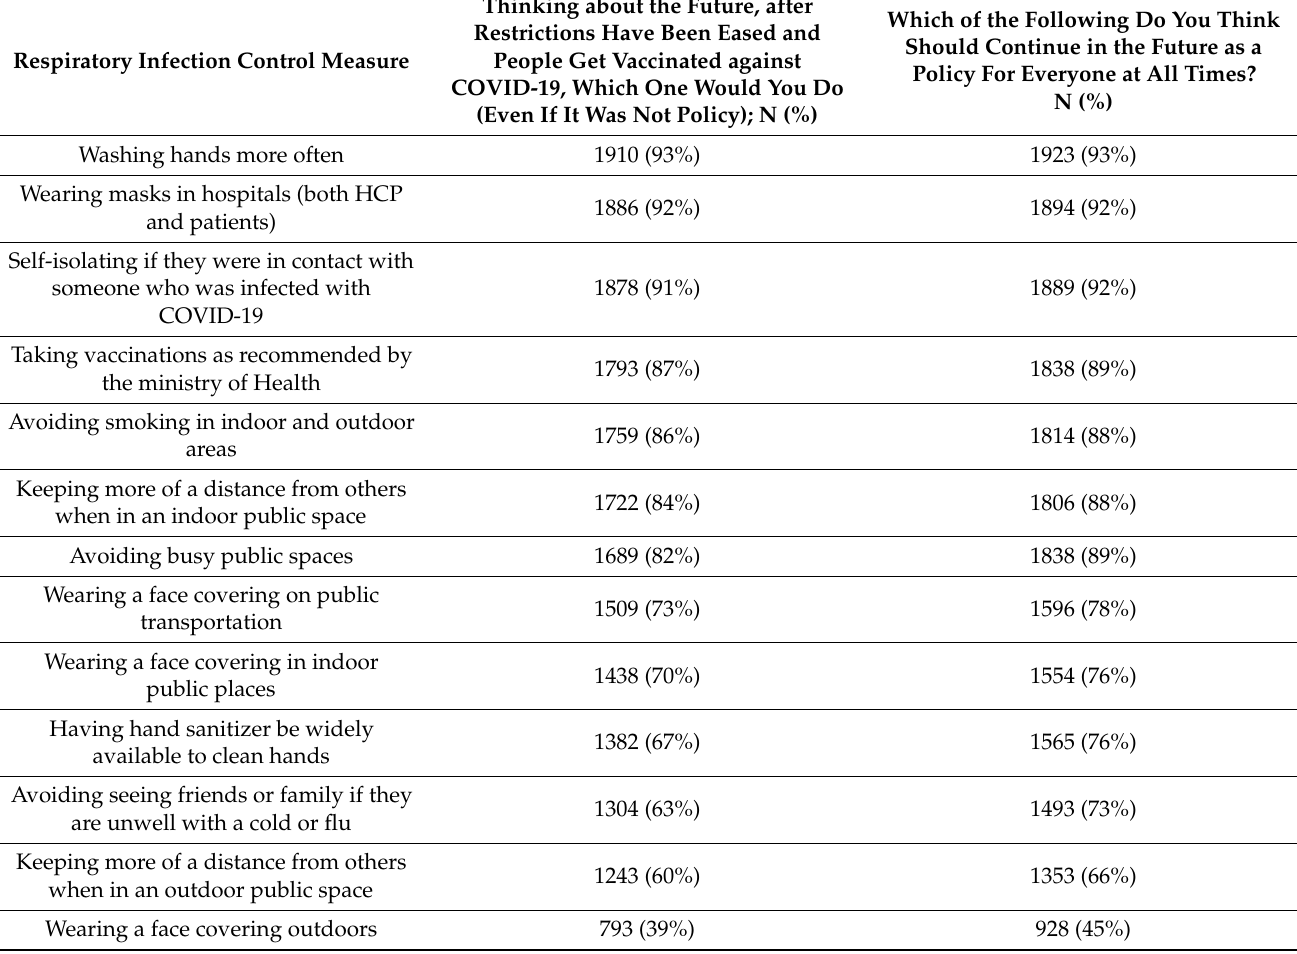
Table 2. Acceptability of respiratory virus infection control interventions. Data are percentages of participants answering yes (n = 2057). BOLD indicates a ≥ 70% acceptability